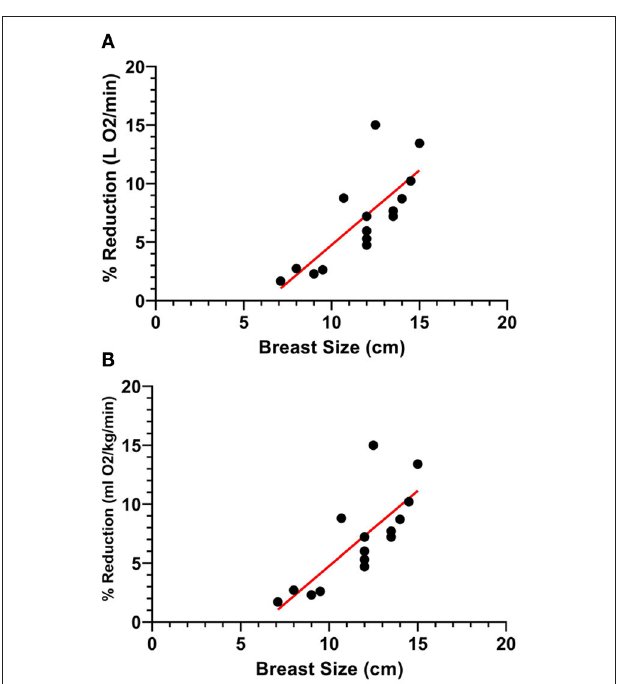
FIGURE 4 | A strong, significant positive relationship was observed between participant breast size (cm) and breast support-induced reductions in (A) absolute and (B) relative oxygen consumption during the treadmill running task.